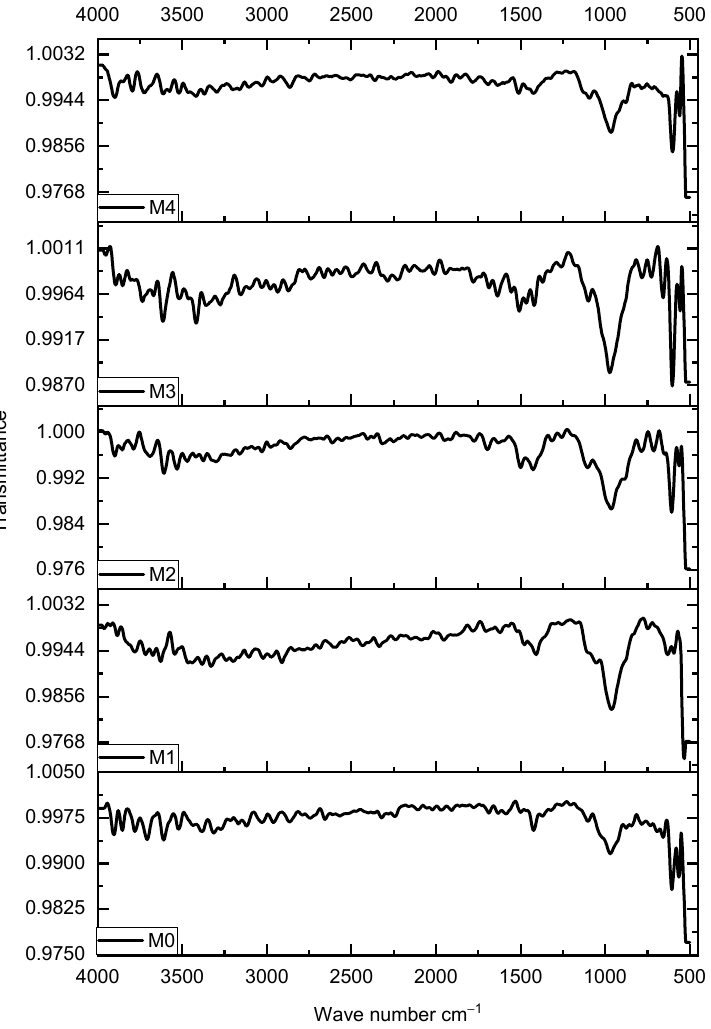
Figure 10. FTIR pattern of BFRFGC for five different mixes.